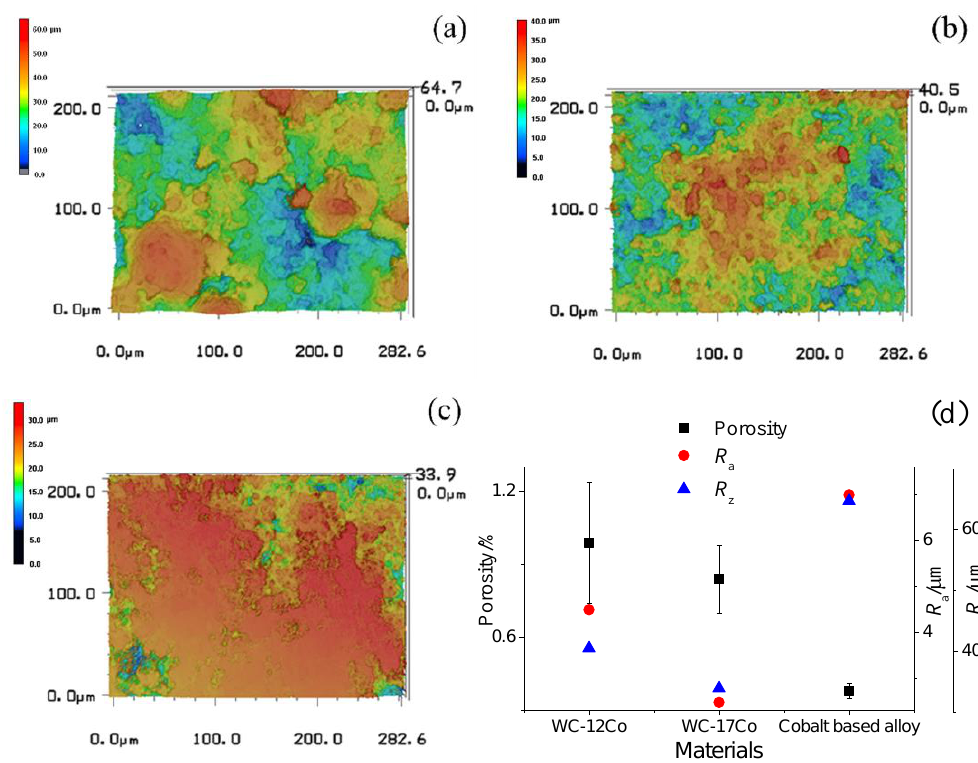
Figure 4. 3D surface morphologies of the coatings: ( a ) Cobalt-based alloy, ( b ) WC-12Co, and ( c ) WC-17Co. ( d ) The porosity and surface roughness of the coatings.